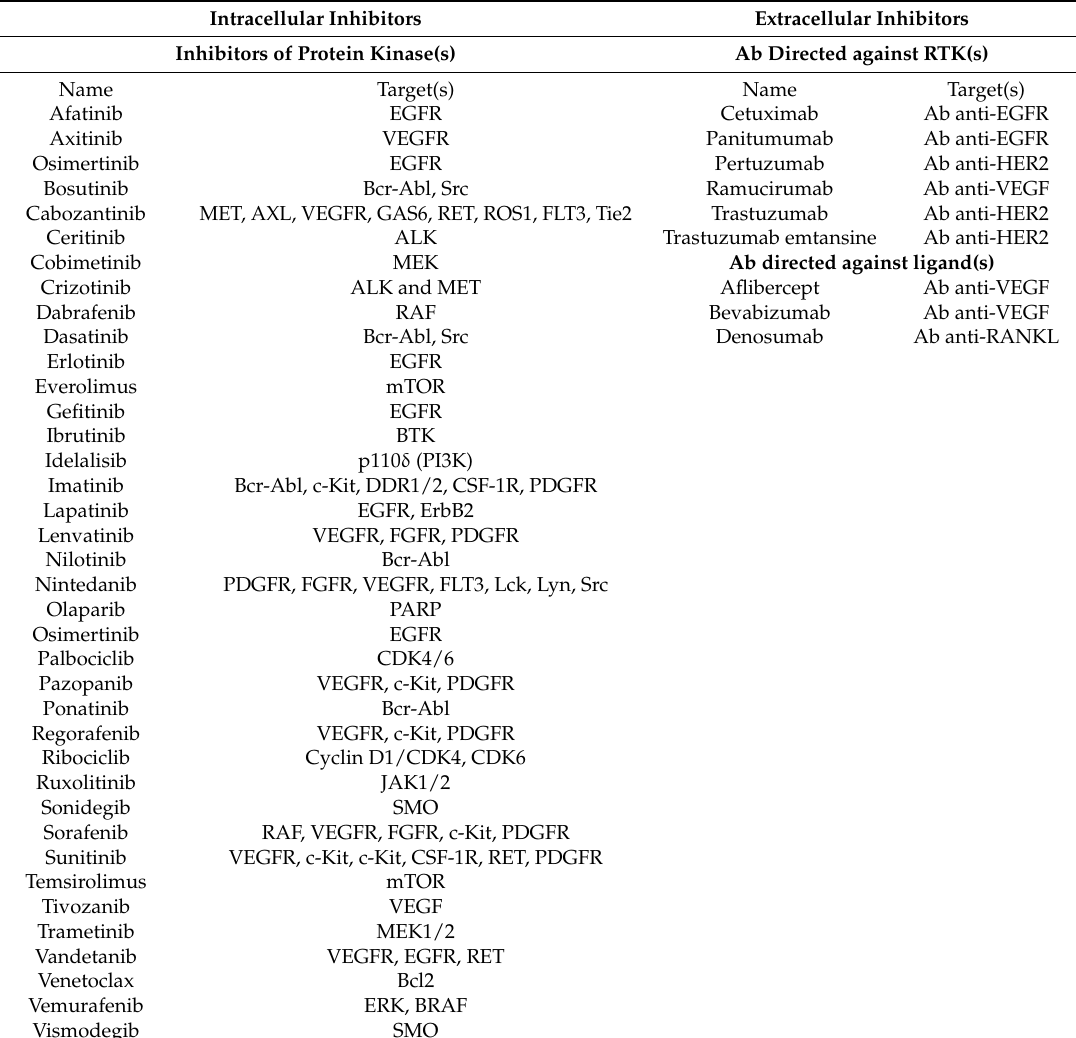
Table 2. List of the 47 anti-cancer targeted therapies authorized in France. Adapted from INCa data and completed with Vidal.fr, updated in January